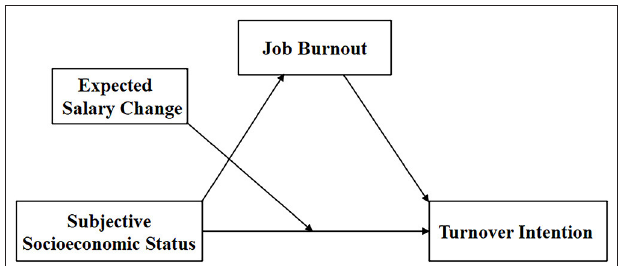
FIGURE 1 | The proposed moderated mediation